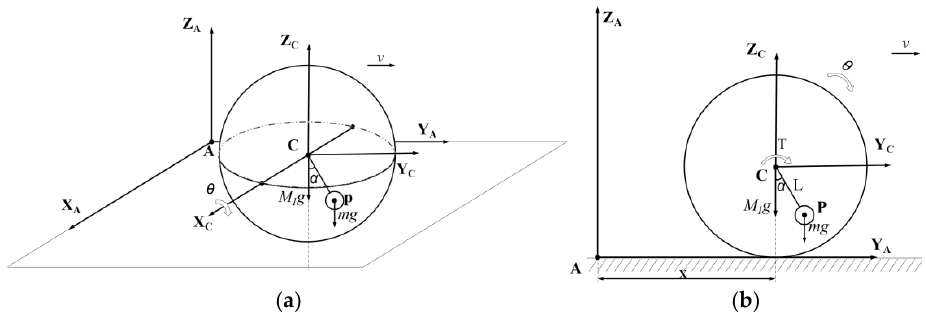
Figure 11. ( a ) Schematic diagram of rolling movement; ( b ) View of Y A Z A -plane of the schematic diagram of rolling movement.